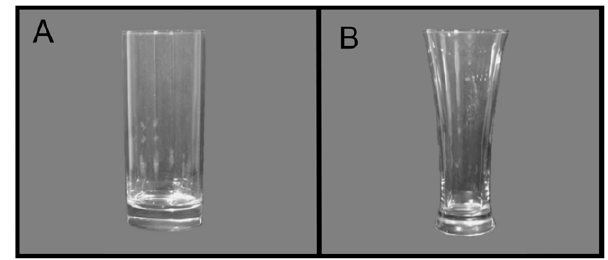
Figure 1. Straight-sided (A) and Curved (B) Glasses.